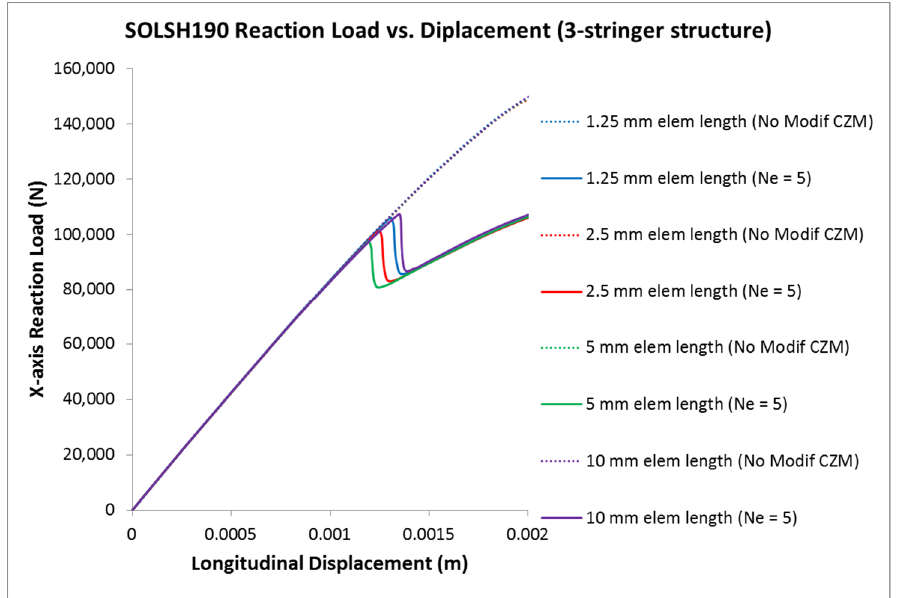
Figure 9. ( a , b ) FE contour plot of the out-of-plane displacement, when modification of the maximum normal and shear traction parameters of the CZM is used and when is not used, for a 3-stringer structure case.